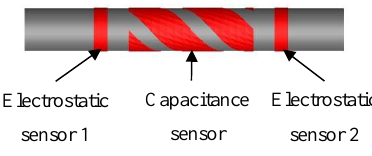
Figure 2. Sensor configuration.